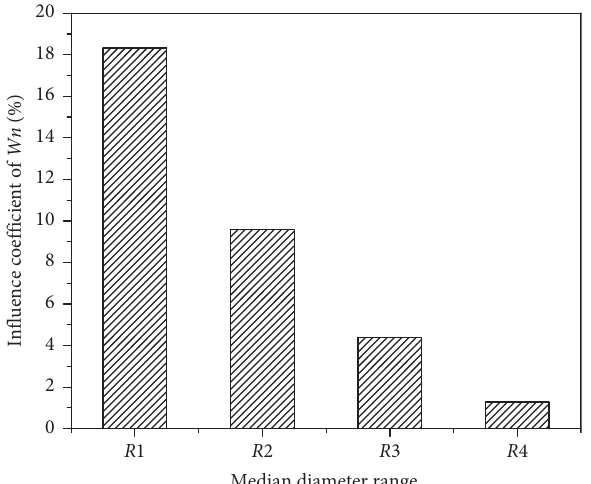
Figure 11: Influence coefficient of steel slag powder with different particle sizes on nonevaporable water content of blended